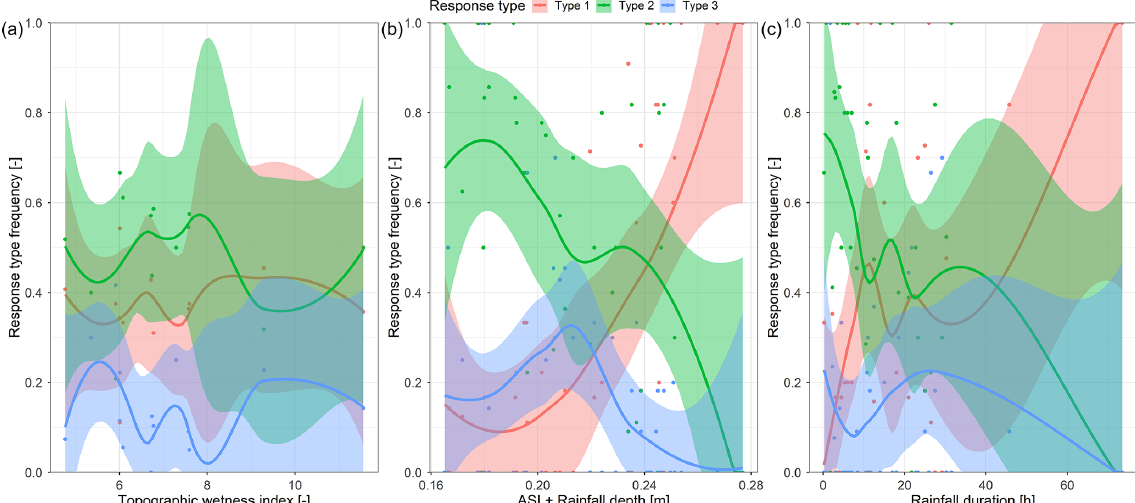
Figure A3. Soil moisture response-type frequency over station topographic wetness index (a) , a sum of antecedent wetness (ASI) and event rainfall depth (b) and rainfall event duration (c) . Colours represent different response types as defined in Sect. 2.6. Points are calculated values of response-type frequencies; lines are local regression fits for each response type and the shaded areas corresponding to 95% confidence